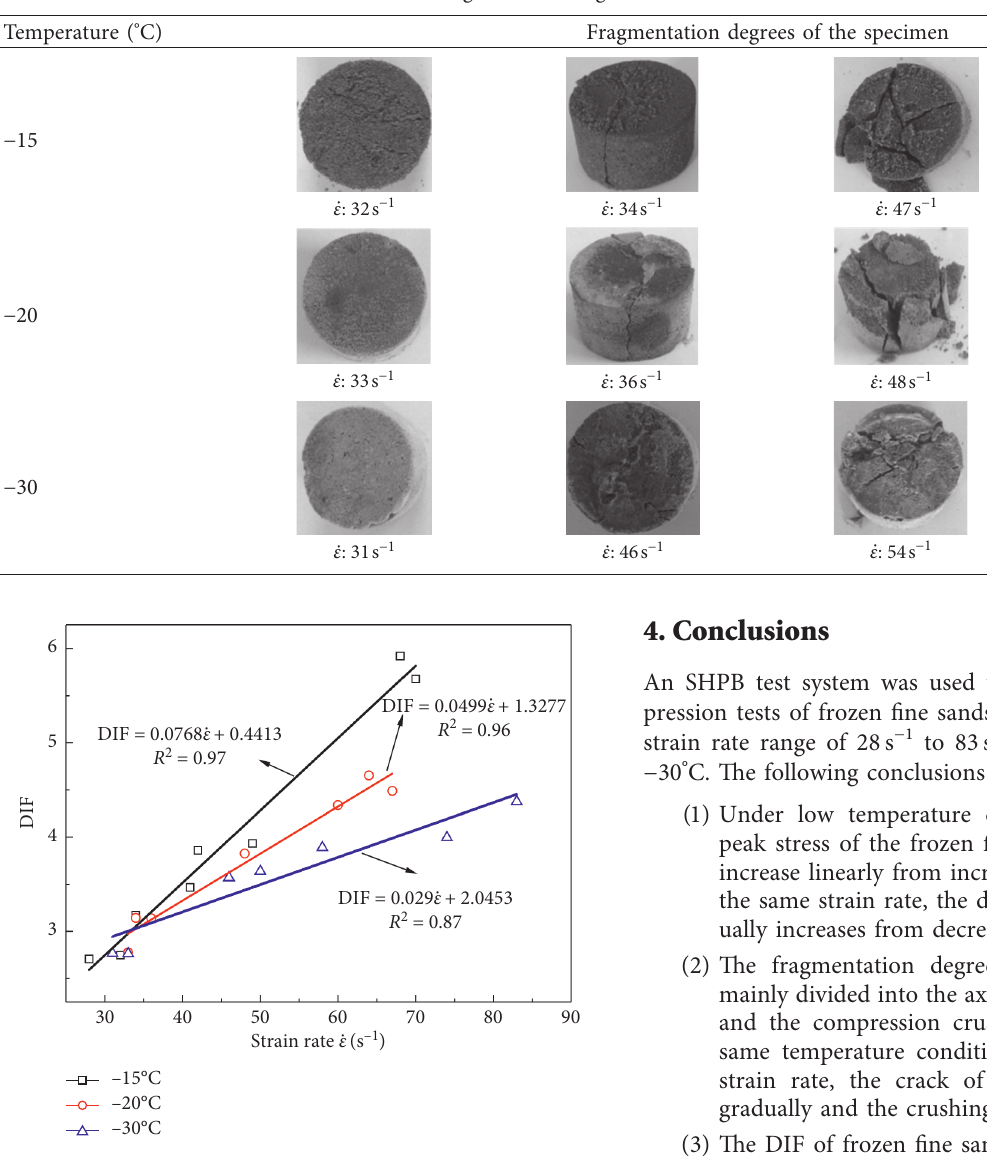
Figure 8: Relationships between the DIF and the strain rate at different temperatures.